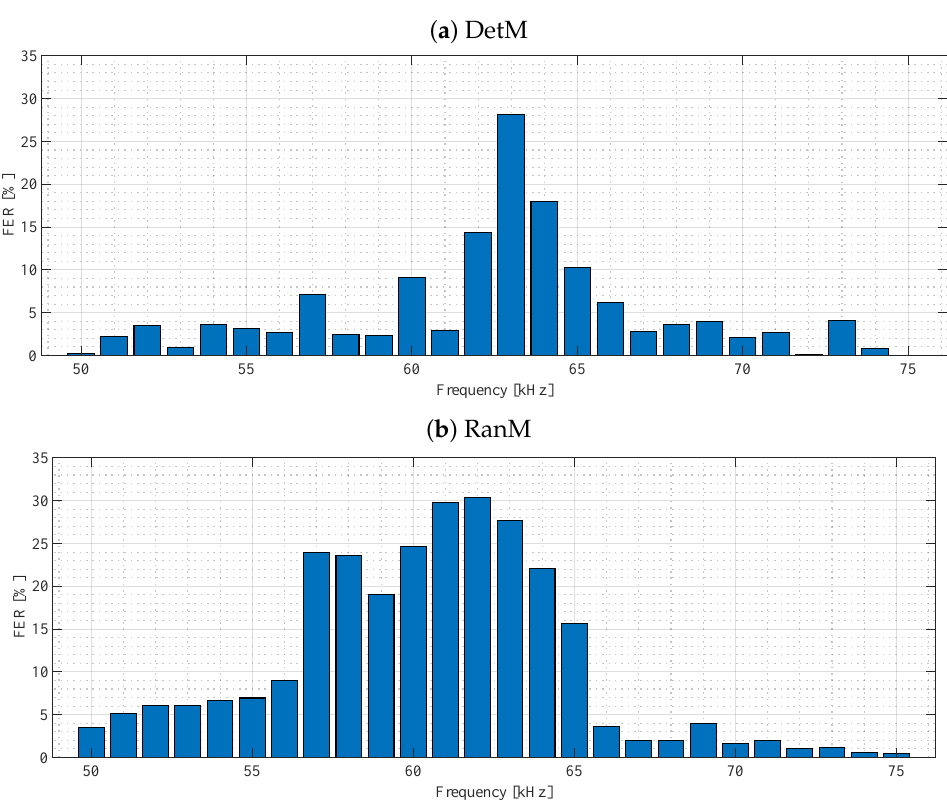
Figure 13. The FER percentage vs. the variation in the main switching frequency values around the intermediate frequency of the G3-PLC bandwidth for DetM ( a ) and RandM ( b